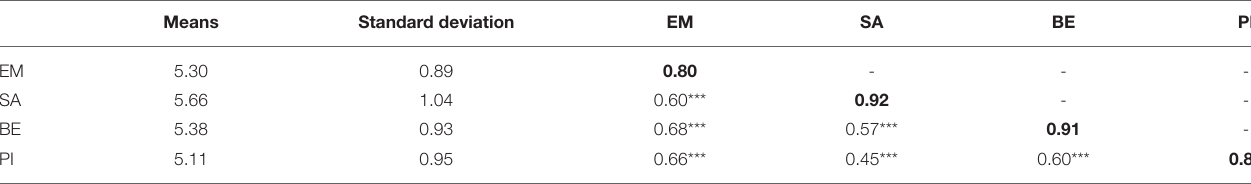
TABLE 3 | Descriptive statistics, variance explained, and correlations.